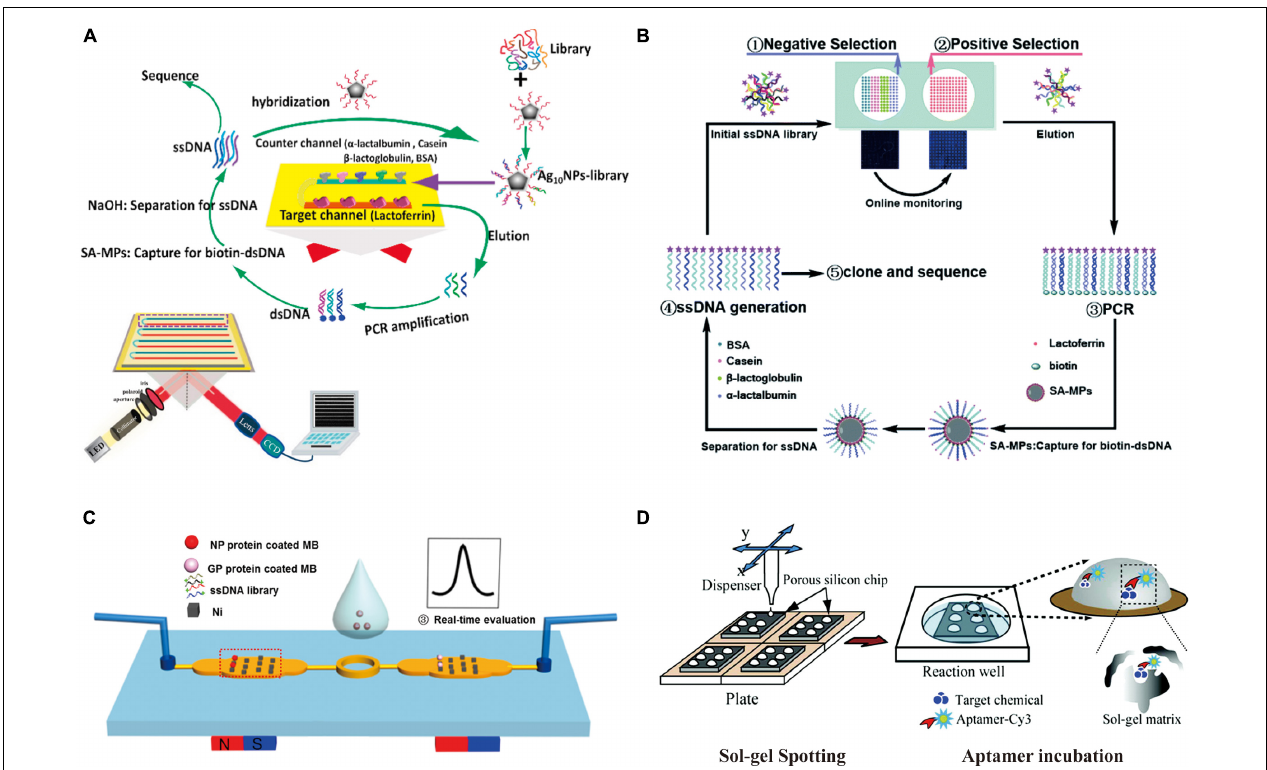
FIGURE 2 | Microarray chips for aptamer selection. (A) Schematic diagram of the Ag10-NPs-library SPRI-microfluidic-SELEX method. The biochip consists of eight parallel channels on an SAM-gold substrate sealed in a customized flow cell. (B) Principle of microarray-SELEX for aptamer screening. (C) Magnetism-array selection chip. Reprinted with permission from Hong et al. (2017). Copyright 2018 American Chemical Society. (D) Schematic of the PS–SG in vitro selection aptamer chip, where small target molecules are entrapped in a spotted sol–gel microarray, which is then incubated with